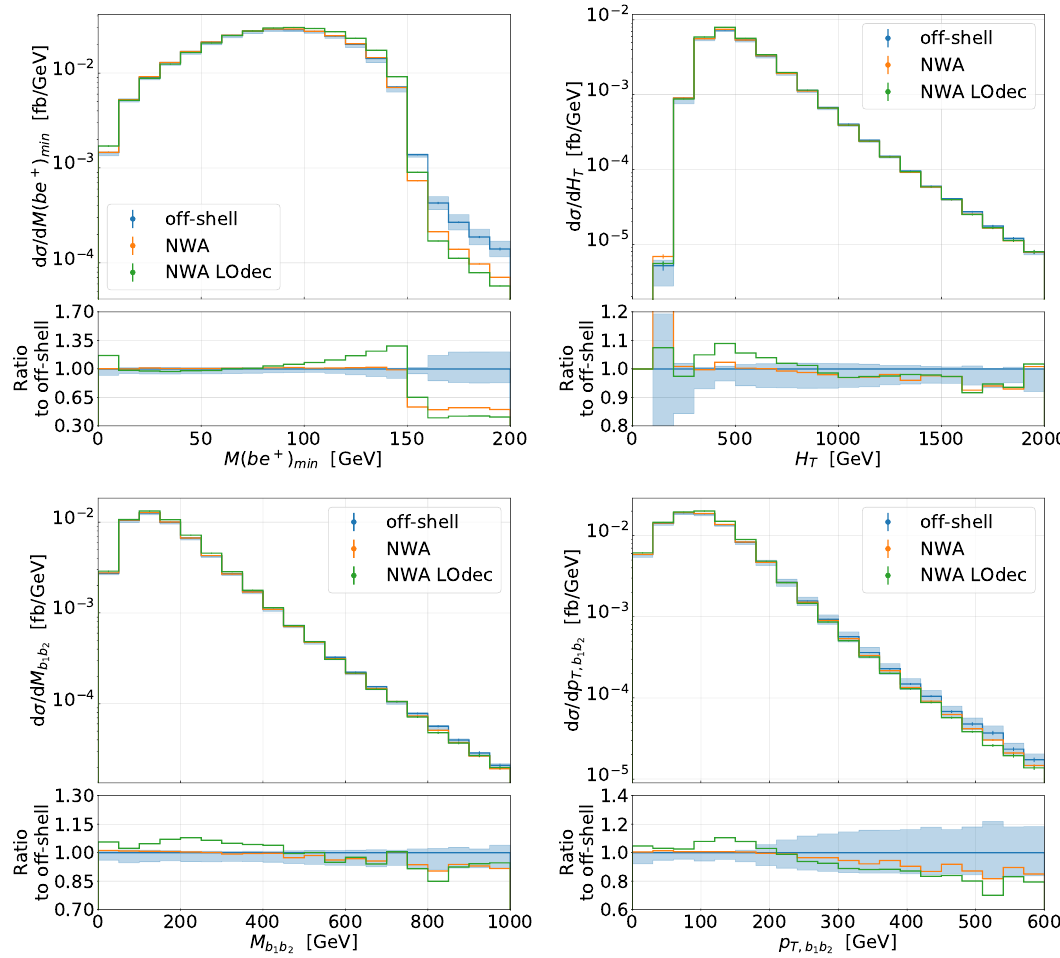
Figure 12 . Differential distributions at NLO QCD for the observables M ( be + ) min , H T , M b p T,b for the pp → e + ν e µ − ¯ ν µ b ¯ b H process at the LHC with 1 b 2 for µ 0 = H T / 2 . The NNPDF3.1 PDF set is employed. The upper panels show full off-shell,